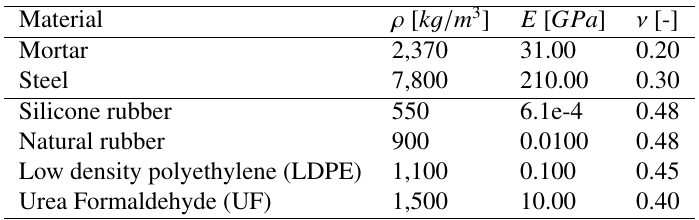
Table 1. Material